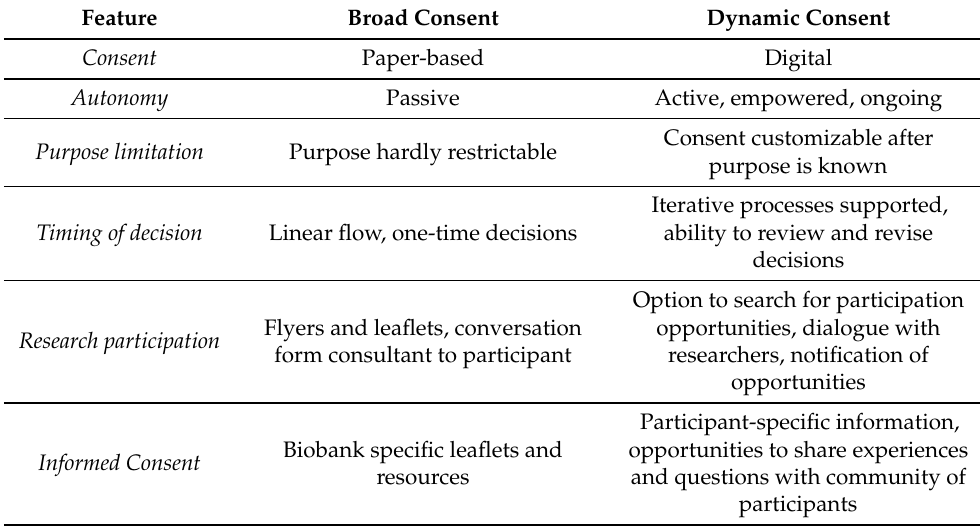
Table 1. Comparison of Broad and Dynamic Consent